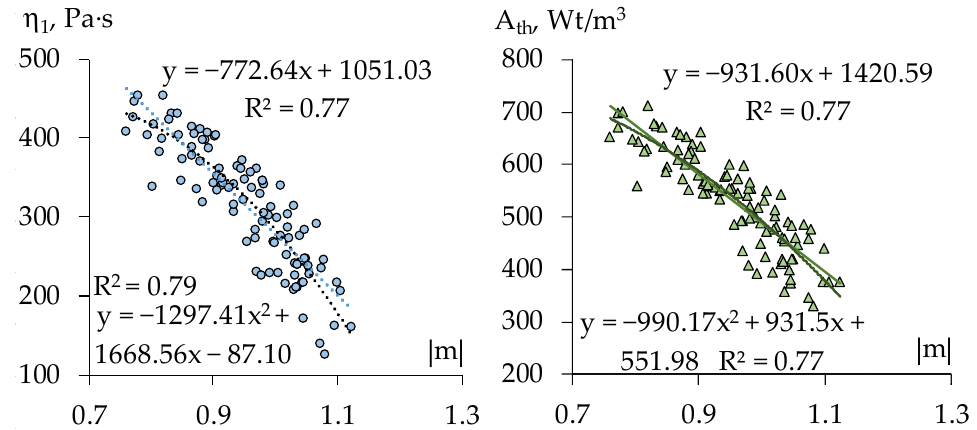
Figure 8. Scatter diagrams of the estimates of rheological characteristics at upper content of perlite and methylcellulose (x 2 = x 3 = +1) obtained in computational experiments with the help of ES-models (results of one trial).